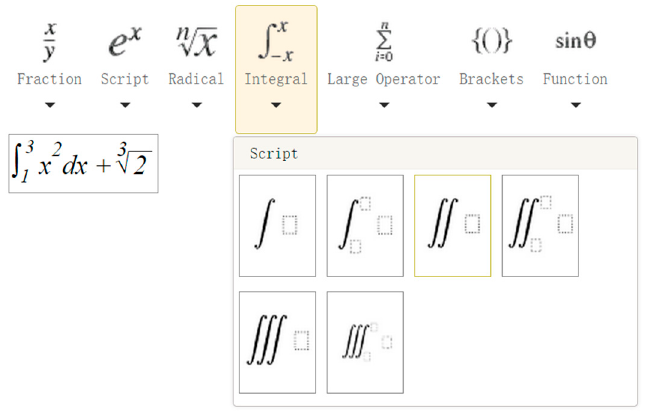
Figure 9. Entering equations: simplified visual